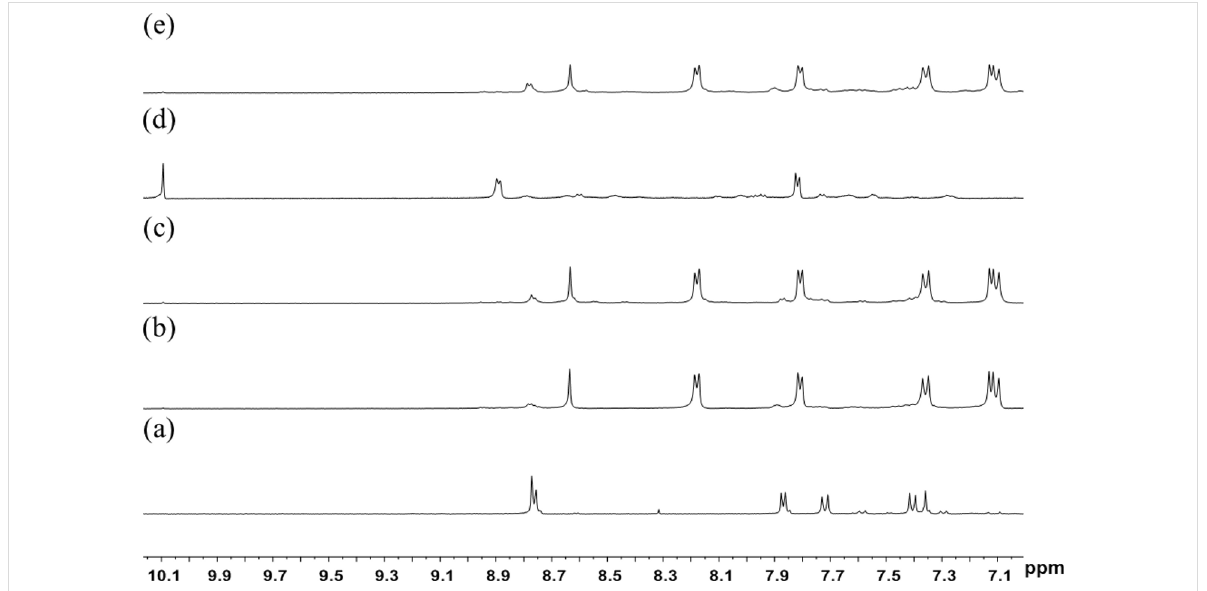
Figure 1: Partial 1 H NMR spectra (400 MHz, DMSO- d 6 , ppm) of (a) L1 ; (b) the sample of metallarectagle 3a obtained by coordination-driven self- assembly of organometallic clip 1 and L1 (method A); (c) the sample of metallarectagle 3a obtained through [4 + 4] condensation reactions of half- sandwich rhodium-based dialdehyde complex 2 with trans -4,4'-stilbenediamine (method B); (d) half-sandwich rhodium-based dialdehyde 2 ; (e) the product of self-assembly of organometallic clip 1 , trans -4,4'-stilbenediamine and 4-formylpyridine in a one-pot procedure (method C).